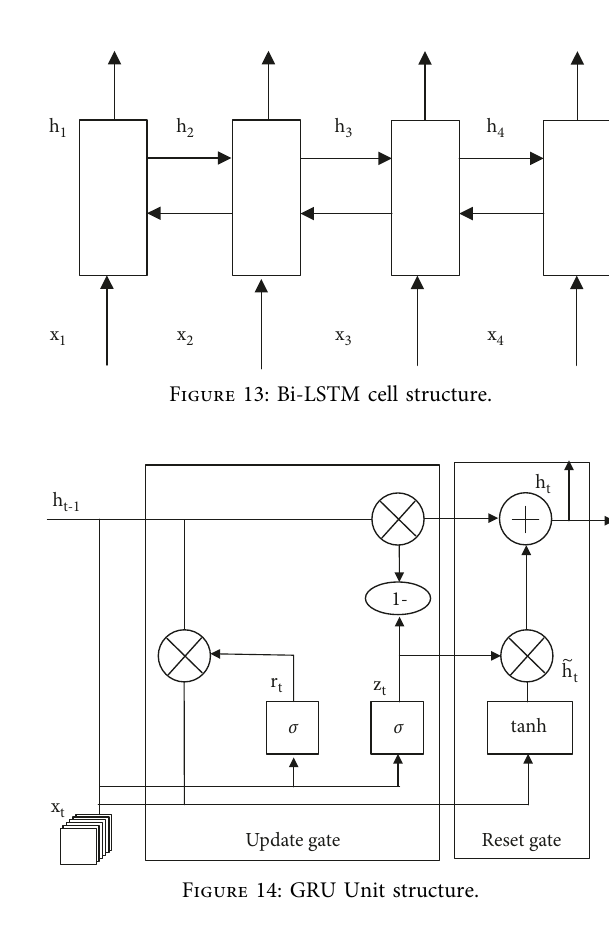
Figure 14: GRU Unit